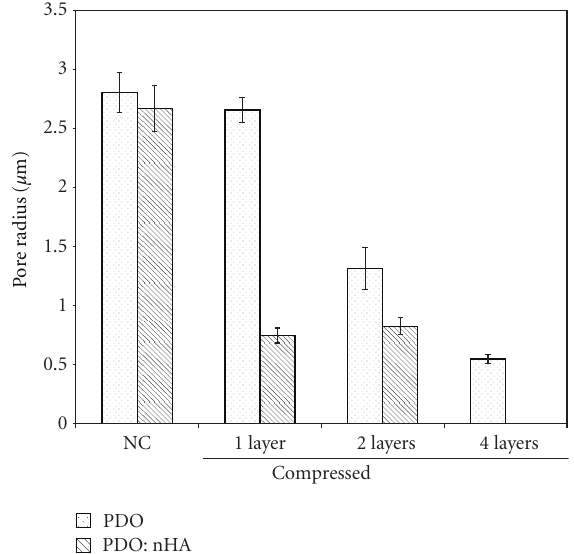
F 6: Effect of compression of PDO and PDO:nHA scaffolds on pore size. Non-compressed (NC) scaffolds are single layers.